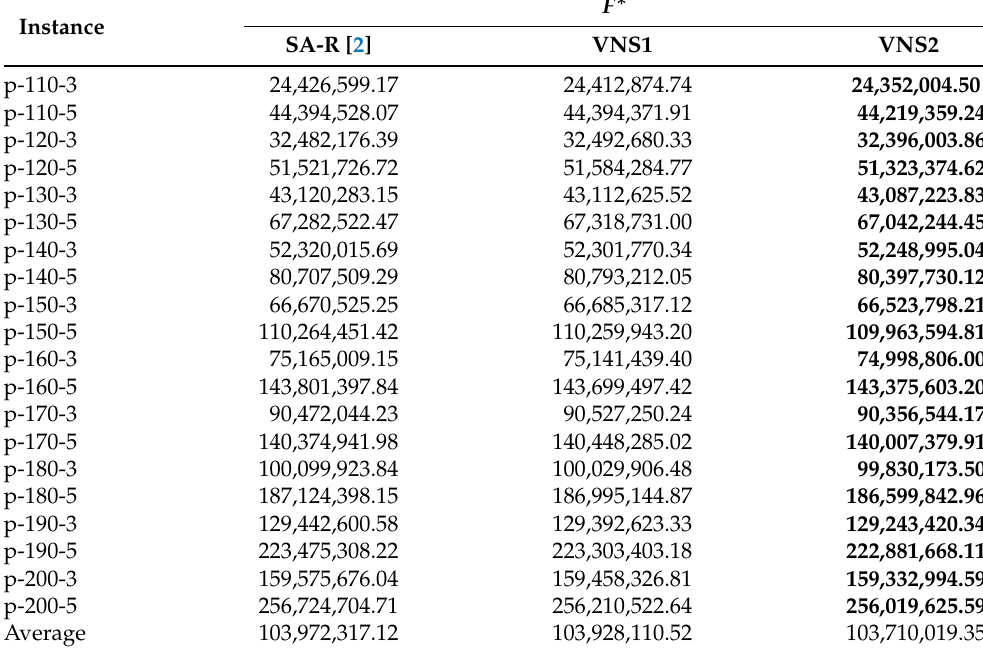
Table 5. Best results of VNS1, VNS2, and SA-R for larger-size